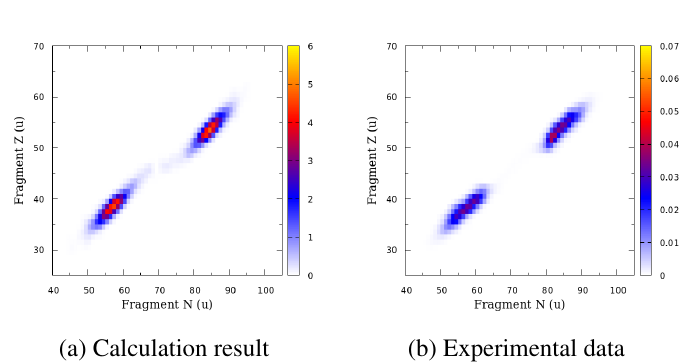
Figure 3. The calculation result of fission fragment distribution on the N-Z plane for 236 U (E ∗ = 10 MeV) is plotted. It is compared with the experimental data of 235 U neutron-induced fission (E k = 500 KeV) from JENDL-4.0